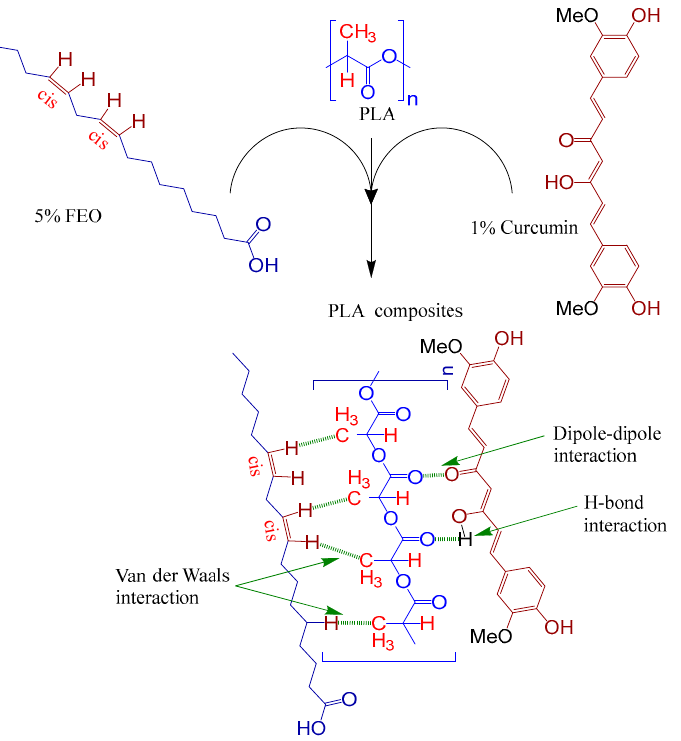
Figure 1. Schematic process diagram for the synthesis of the PLA-based films.